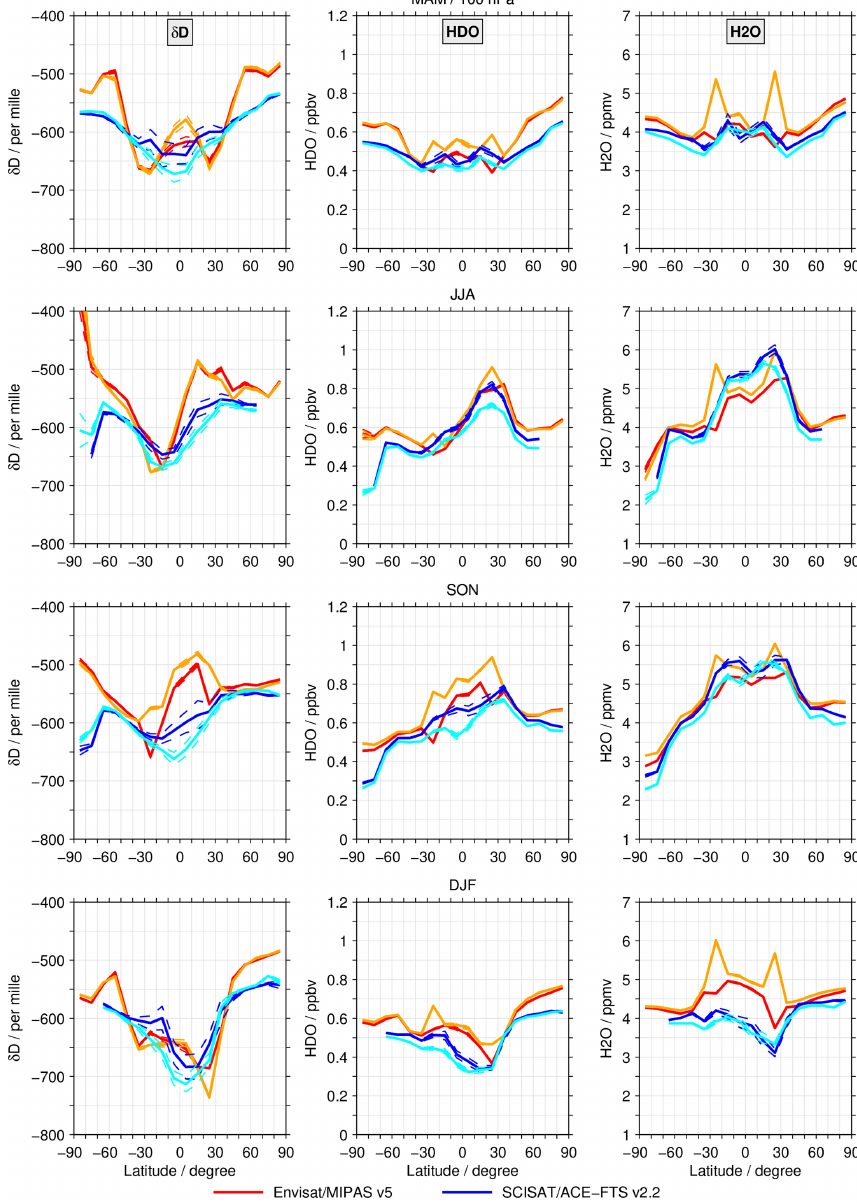
Figure 4. Latitude cross sections at 100hPa from the different data sets for δ D (left column panels), HDO (centre column panels), and H 2 O (right column panels) for all seasons (different rows). The thin dashed lines show the standard error of the binned data.